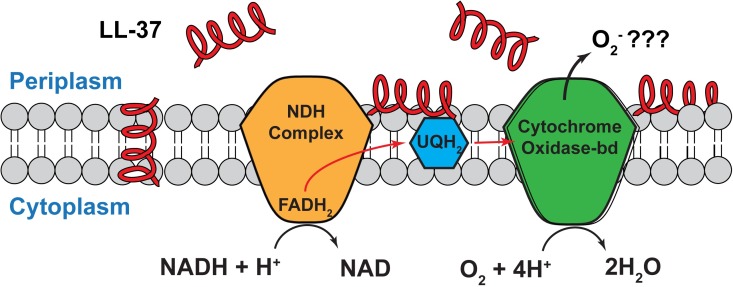
Schematic of the branch of the aerobic electron transport chain of E. coli terminating at cytochrome oxidase-bd.We suggest that LL-37 enters the periplasm, binds to the outer leaflet of the cytoplasmic membrane, and disrupts the proper activity of the terminal cytochrome oxidase-bd complex, releasing the intermediate superoxide (•O2–) into the periplasm.